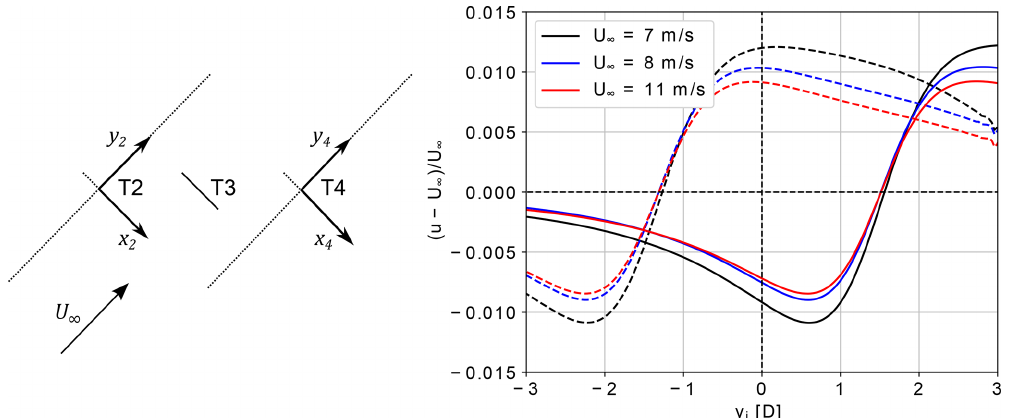
Figure 6. Velocities induced by the central turbine (T3) on the rotor axis of T2 (solid line) and T4 (dashed line), for different values of U ∞ , turbine inter-spacing of 2D and θ = 45 ◦ .